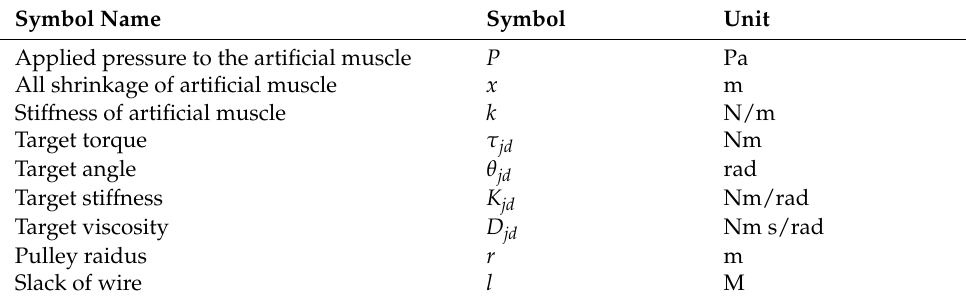
Table 1. Parameter of the viscoelastic